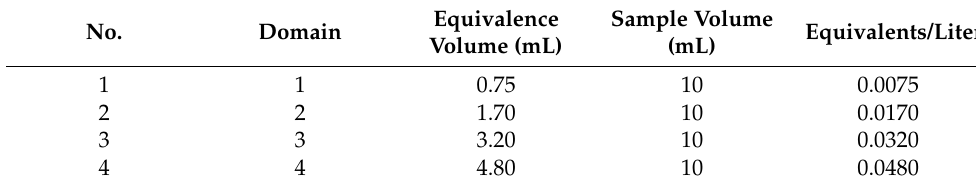
Figure 1. Conductometric titration curve of γ -keratose solution. Table 1. Acid equivalents from γ -keratose calculation.